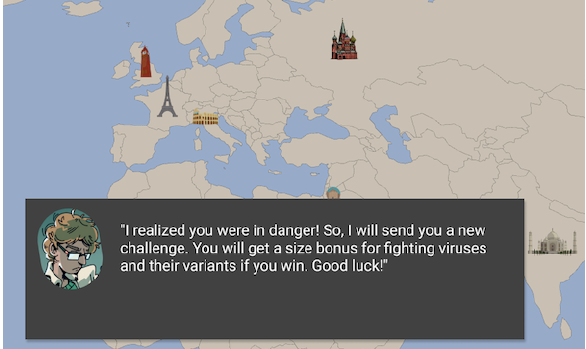
Figure7. Amessagepopsuponthemapfromthescientistworkingremotely to help the player gain a size bonus to fight the virus and its variants. If the player accepts the challenge, Minigames 1 and 2, on the game levels 2 and 3 , respectively, will initiate